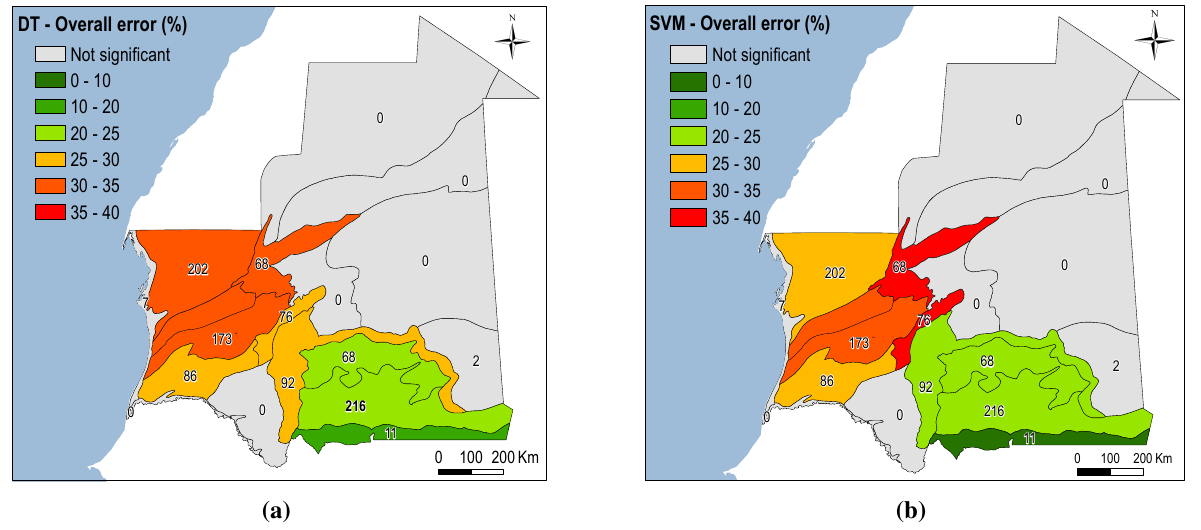
Figure 6. Distribution of the overall error distribution ( 1 − OA ) in the different macroregions. ( a ) Overall error of the DT and number of data points per macroregion. ( b ) Overall error of the SVM and number of data points per macroregion.